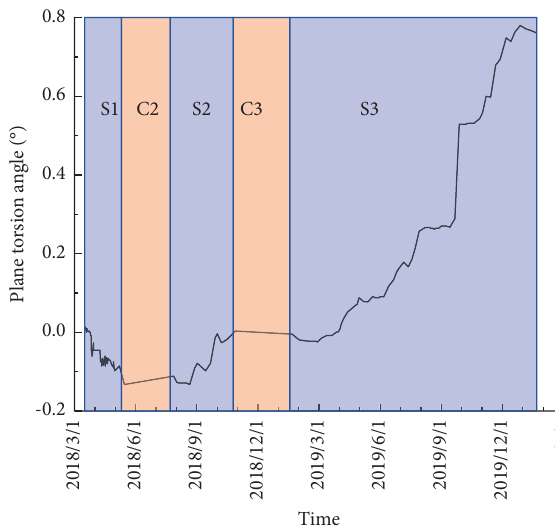
Figure 12: The change of plane torsion angle during caisson